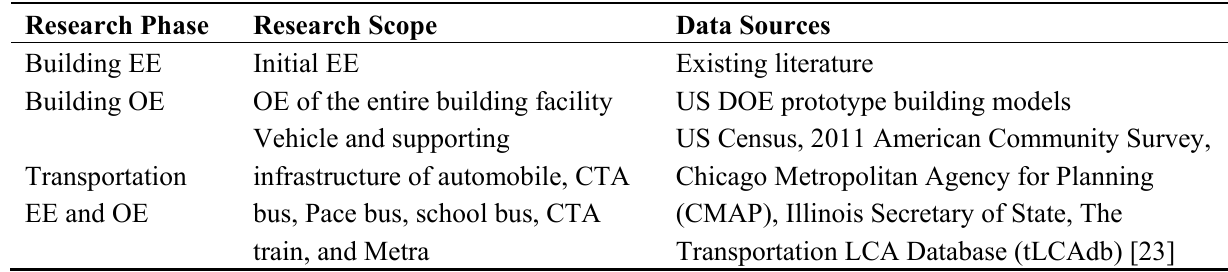
Table 2. Research phase, scope, and data